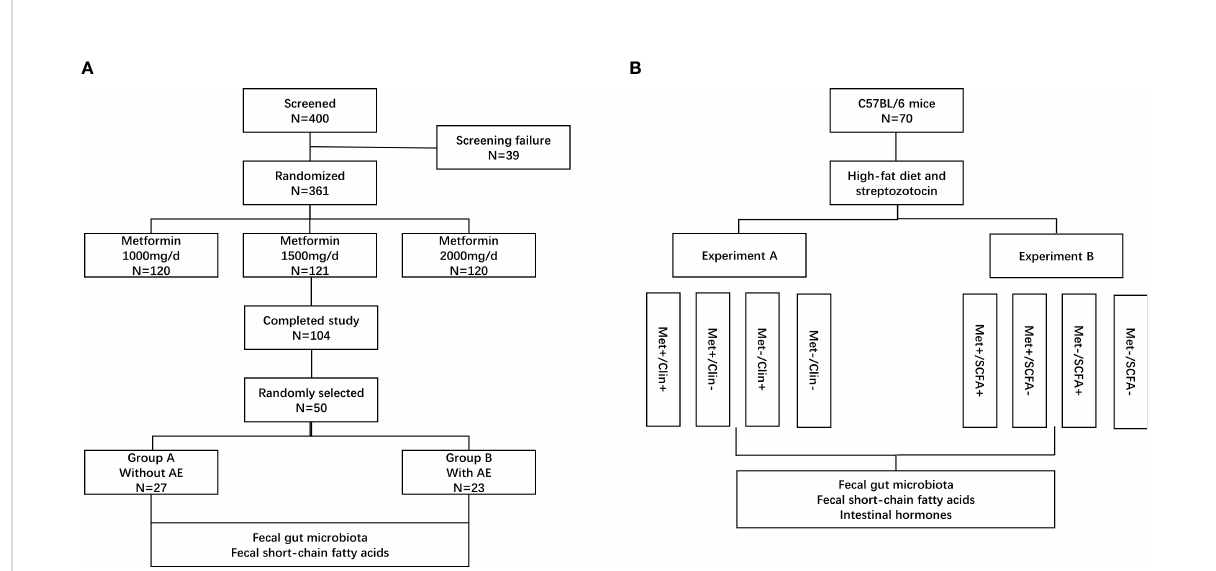
FIGURE 1 Patient disposition and study protocol. AE, adverse events; Met, metformin; Clin, clindamycin; SCFA, short-chain fatty acid. (A) clinical trial; (B) animal